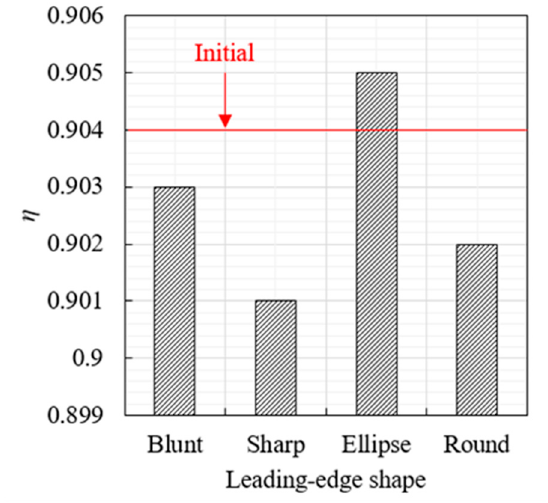
Figure 10. Comparison of the impeller hydraulic efficiency, η , among different impellers.